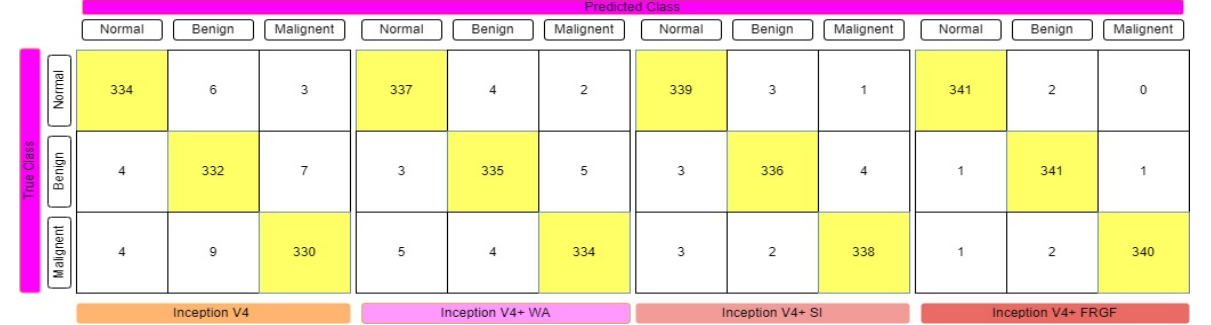
Figure 10. Confusion matrix representation of VGG-11 deep CNN model with various fuzzy ensem-